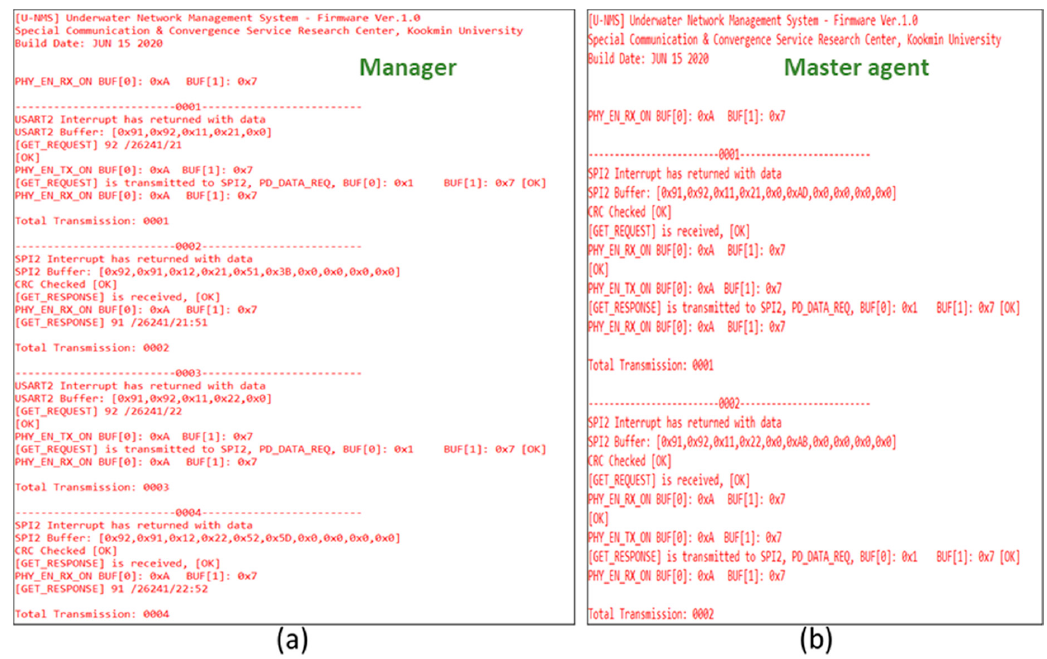
( b ) Results of GET_REQUEST and GET_RESPONSE methods in the master agent side of U-NMS.